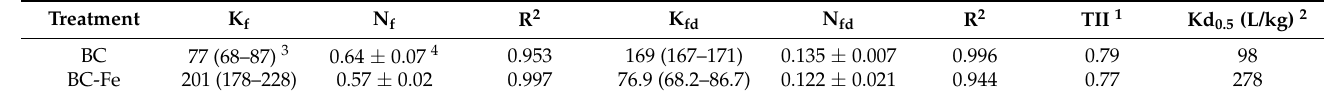
Table 2. Freundlich coefficients for sulfanilamide isotherms on BC and BC-Fe.